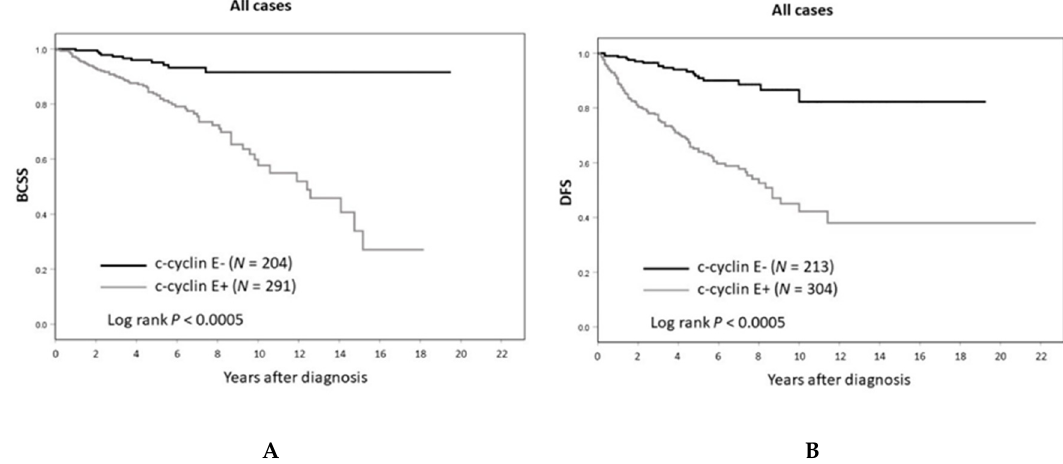
Figure 3. ( A ) Breast cancer-specific and ( B ) disease-free survival by cytoplasmic cyclin E status.